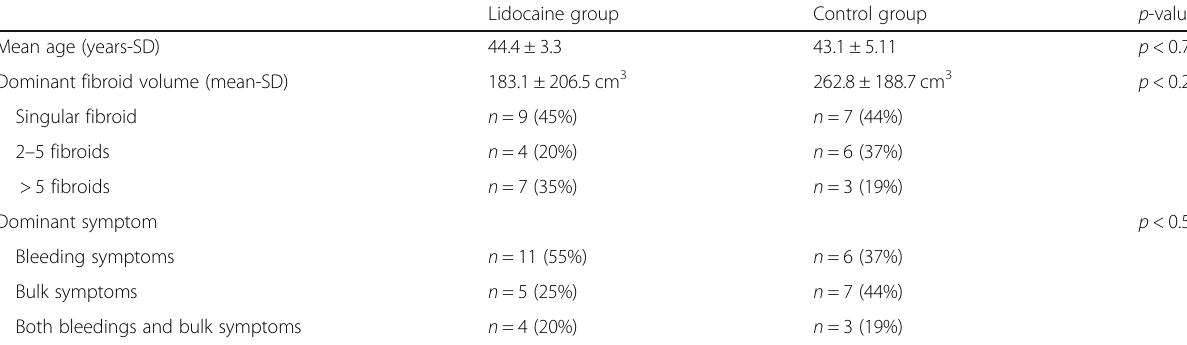
Table 1 Pre-embolization patients and fibroid characteristics